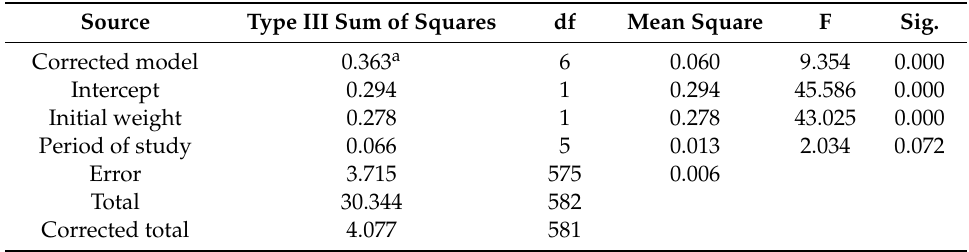
Table 5. Tests of between-subjects e ff ects table, in which the period of study was the independent variable, the initial weight was the covariate, and the ADG was the dependent variable.